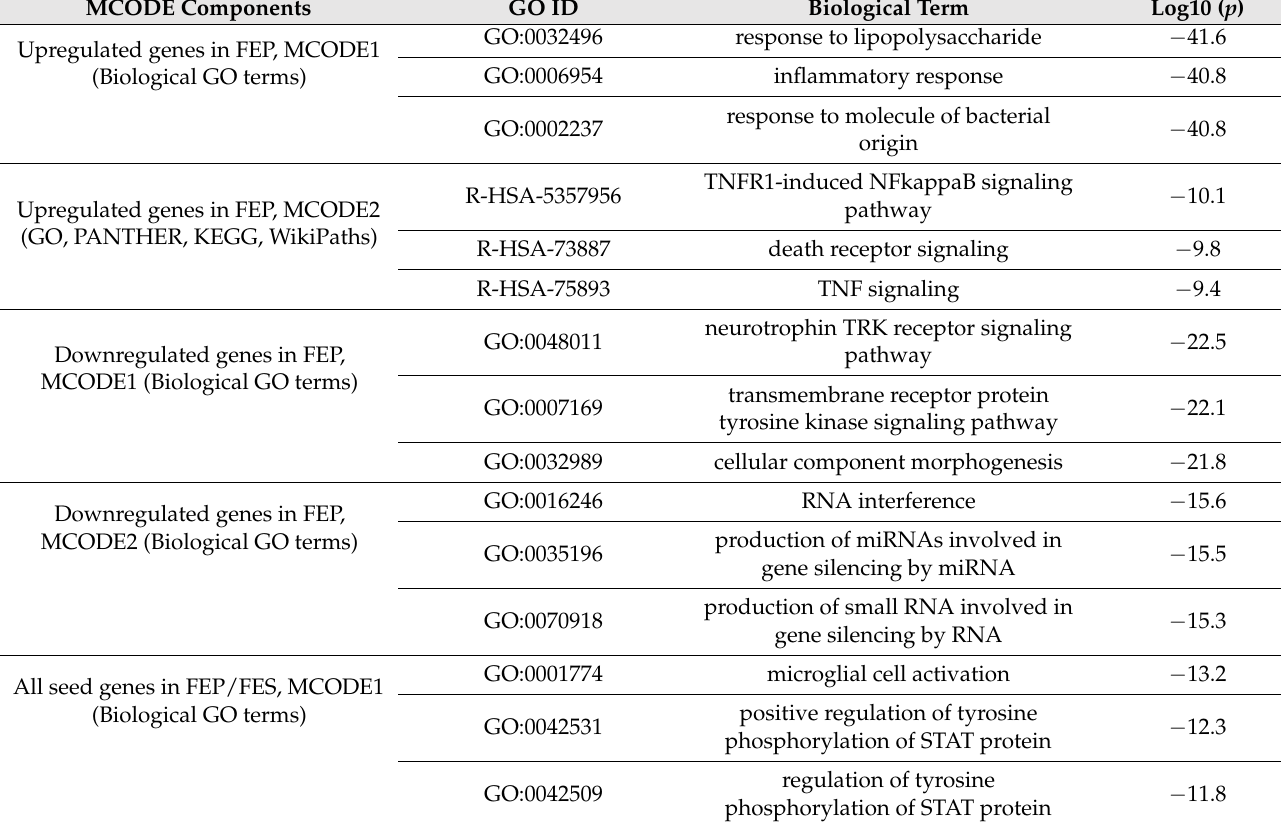
Table 1. Results of Molecular Complex Detection (MCODE) analysis performed on upregulated and downregulated differentially expressed proteins in first episode psychosis (FEP) and/or first episode schizophrenia (FES). MCODE